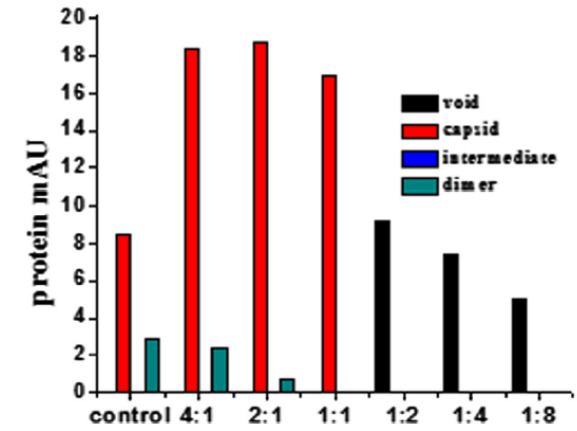
Figure 1: SEC showed the effect of 4a on capsid HBV replication than 3TC (13.9 µM). When the attachments on dihydroisoindolo[2,1- a ]quinazoline-5,11 -dione was replaced by less rigid alkyl groups to give compounds 4c, 4d, 4e, 4f, 4g, 4h (the IC 50 values 12.6 µM, 69.5 µM, 36.6 µM, 22.3 µM, 60.6 µM and 69.5 µM respectively), their anti-HBV activities were reserved or even decreased. Replacing the alkyl attachment to benzylic groups 4j to 4l there is no improvement in anti -HBV activity. There is no effect on the anti HBV activity when the dihydroisoindolo[2,1- a ]quinazoline- 5,11-dione compounds was substituted with cyclo- hexane 4i . Compounds, 4a (IC 50 = 4.13 µM), 4b (IC 50 = 13.6 µM), 4c (IC 50 = 12.6 µM), 4f (IC 50 =22.3 µM) and 4m (IC 50 = 8.4 µM) showed high inhibition of HBV replica- tion. It illuminated that the anti-HBV activity largely depends on the size, length and character of dihydro- isoindolo[2,1- a ]quinazoline-5,11-dione substituent.